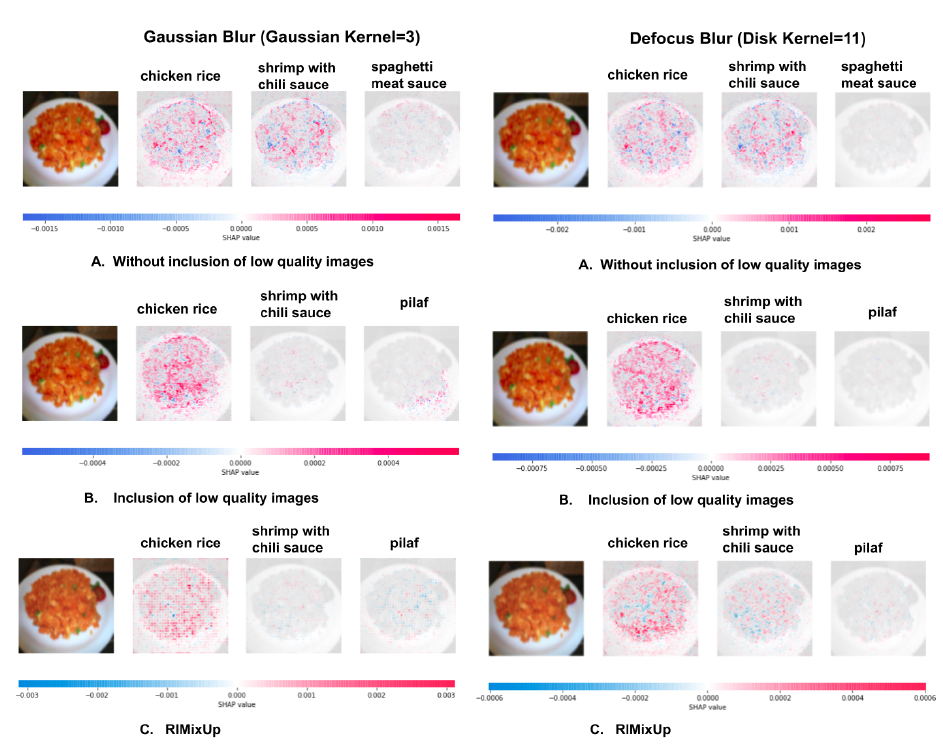
Figure 13. Visualization of the food photo with Gaussian and defocus blur shows that using our strategy prevents the same set of pixels in the image to activate multiple